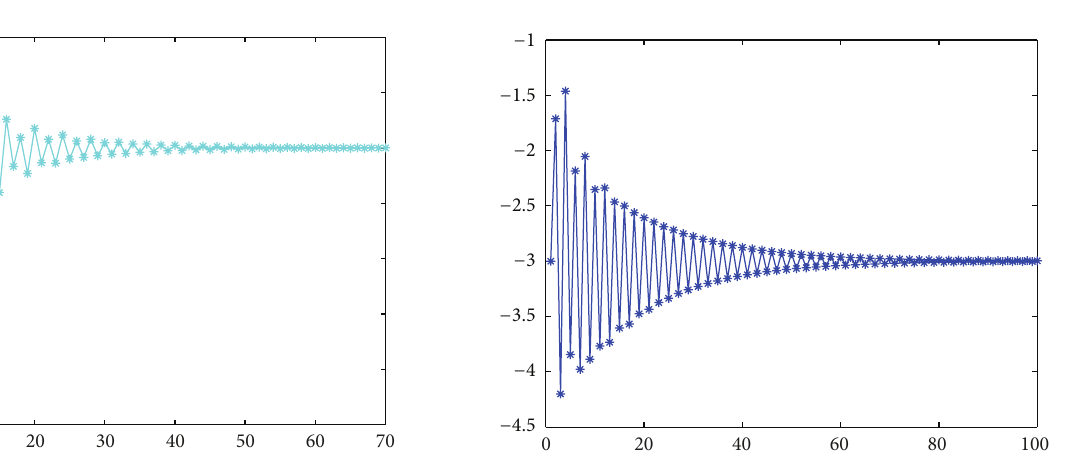
Figure 2: Evolution of 𝑥 𝑛+1 for (1) with parameters and initial condition given in Example